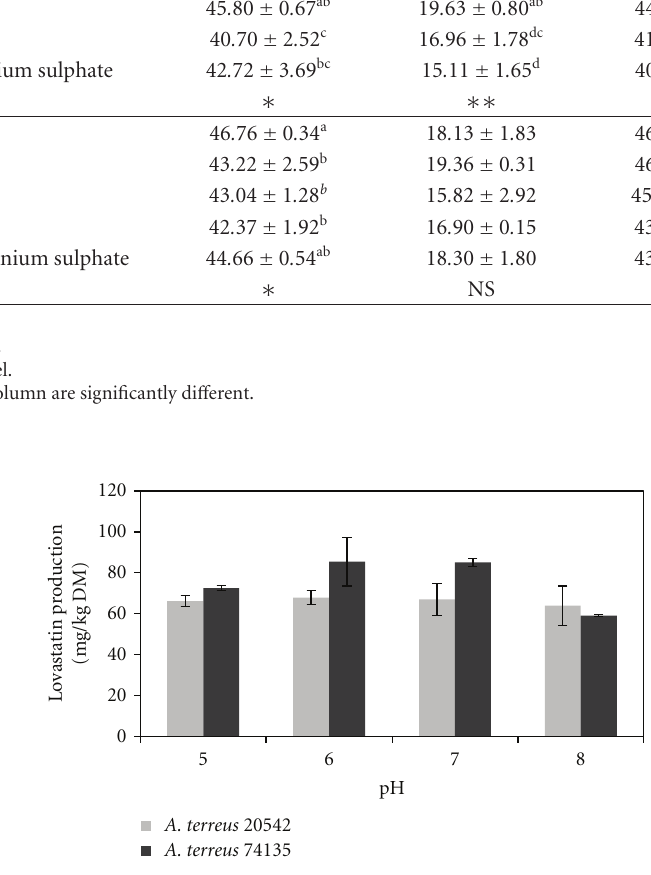
Figure 5: E ff ect of pH on lovastatin production by two strains of A. terreus ( P > 0 . 05).